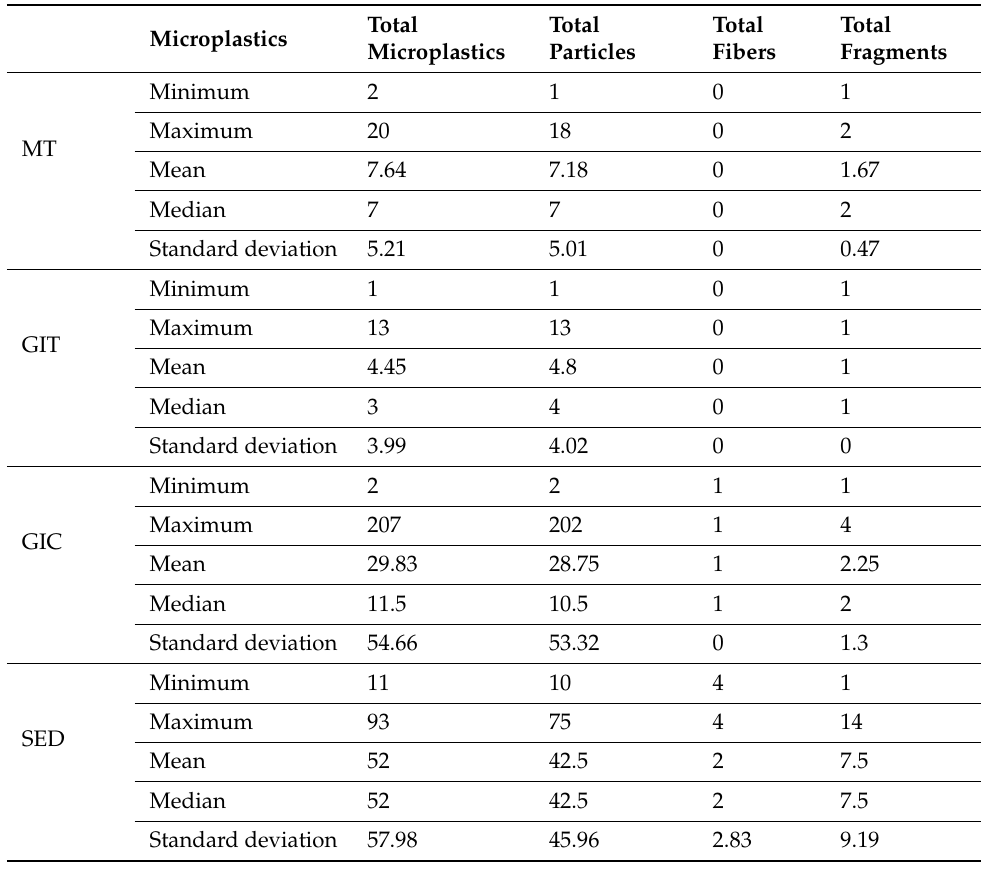
Table 2. Presence of microplastics in Chondrostoma nasus individuals and in the sediments; sediment (SED), gastrointestinal tissue (GIT), the gastrointestinal content (GIC) and muscle tissue (MT).